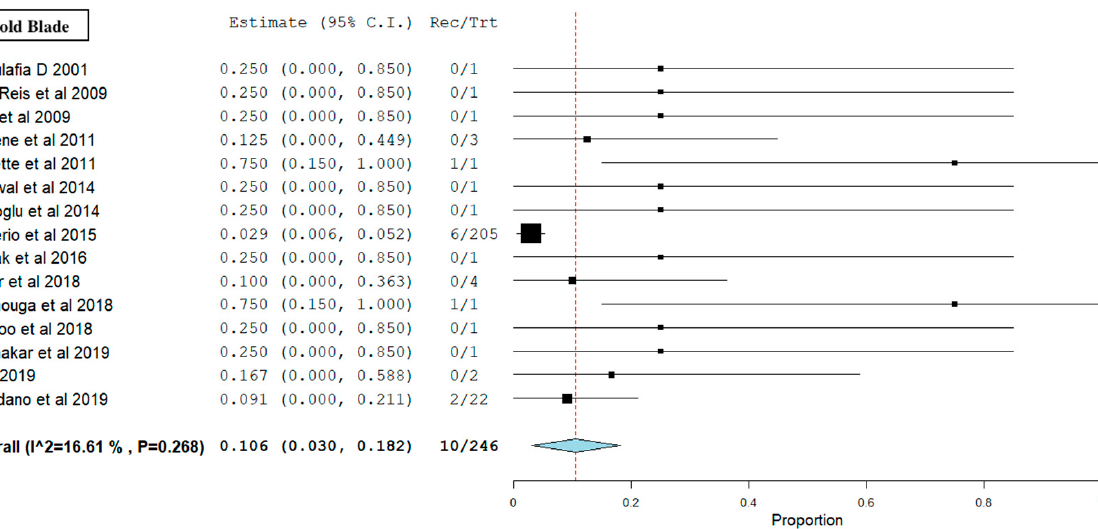
Figure 4. Forest-plot, cold-blade excision studies.